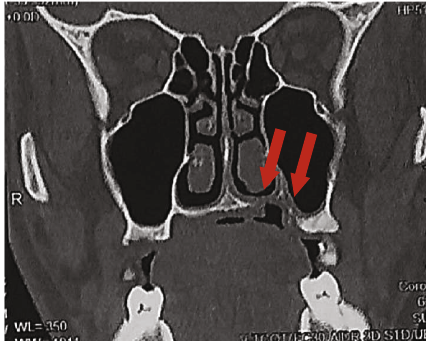
Figure 4: Cone-beam computed tomography (coronal cut) showing the maxillary defect, connecting the oral cavity to the left maxillary sinus and the nasal fossae.